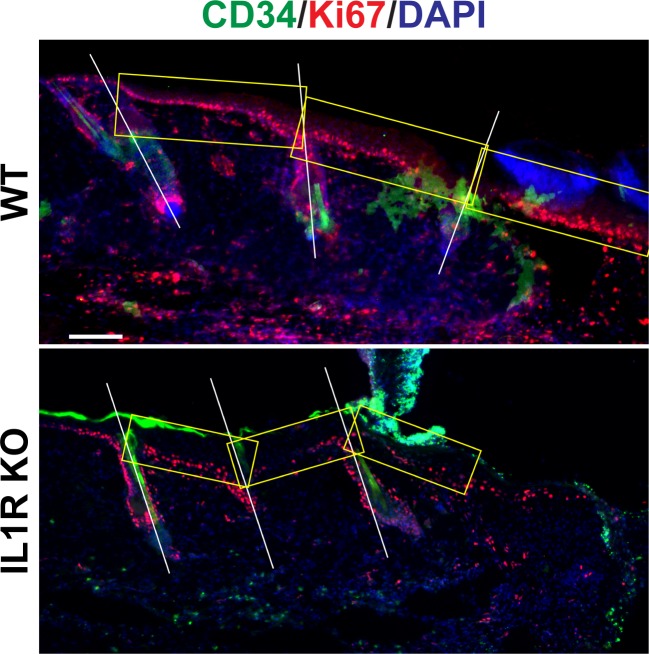
Representative image for Figure 1A.Immunostaining of day 3 wound distal skin sections from 8-week-old WT or IL-1R KO mice for CD34 (green) and Ki67 (red) to mark proliferating HFSCs. Nuclei were stained with DAPI (blue). Scale bar = 50 µm. Boxes are windows taken for quantification of Figure 1A.